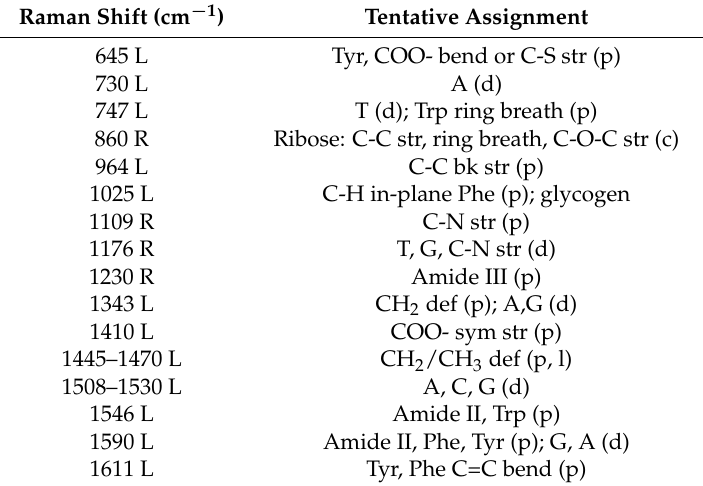
Table 1. The assignments of the Raman bands in SERS difference spectrum of left versus right hemisphere.